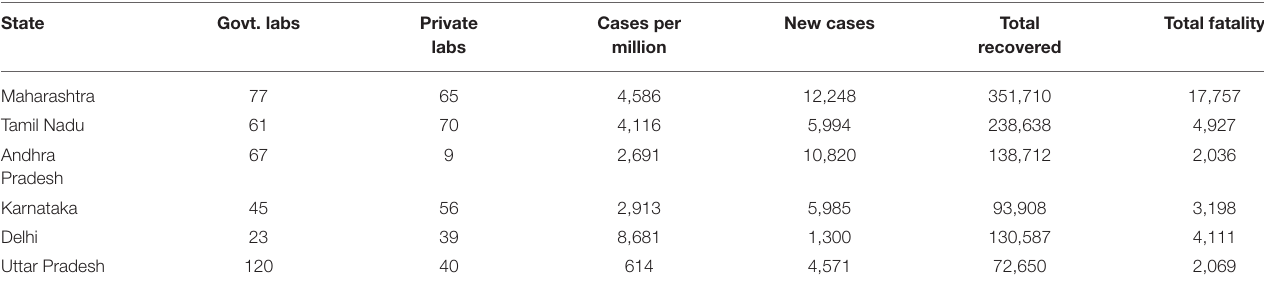
Table with laboratory numbers, cases per million, total recovered, and total fatality for some highly affected Indian states as of August 10,